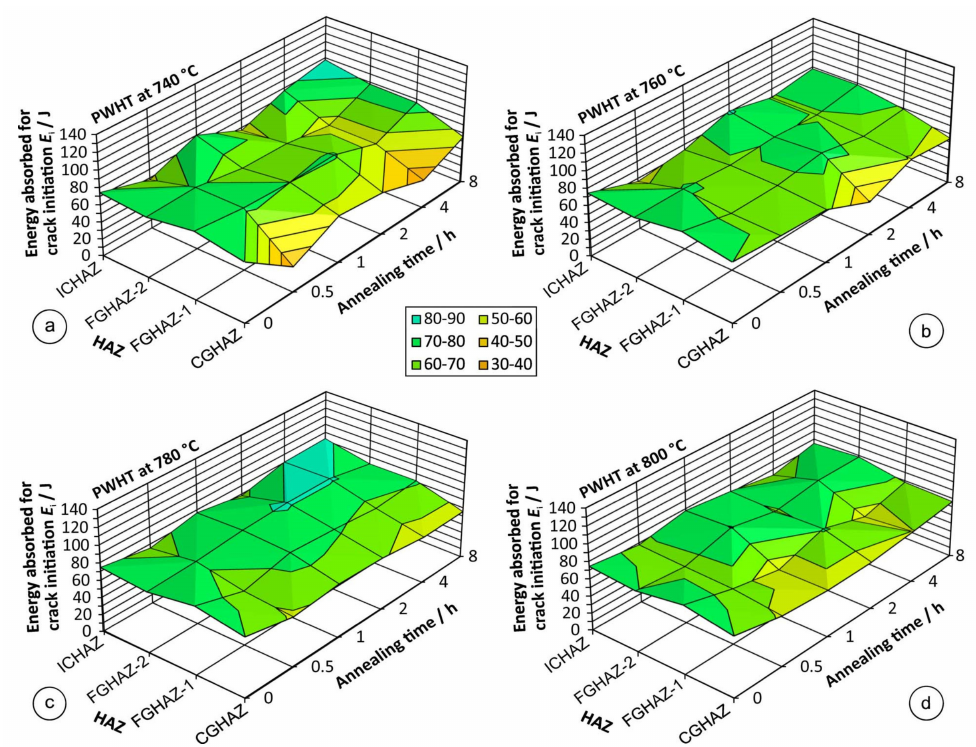
Figure 8. Crack initiation energies E i of HAZ subzones after PWHT at ( a ) 740 ◦ C; ( b ) 760 ◦ C; ( c ) 780 ◦ C; ( d ) 800 ◦ C.